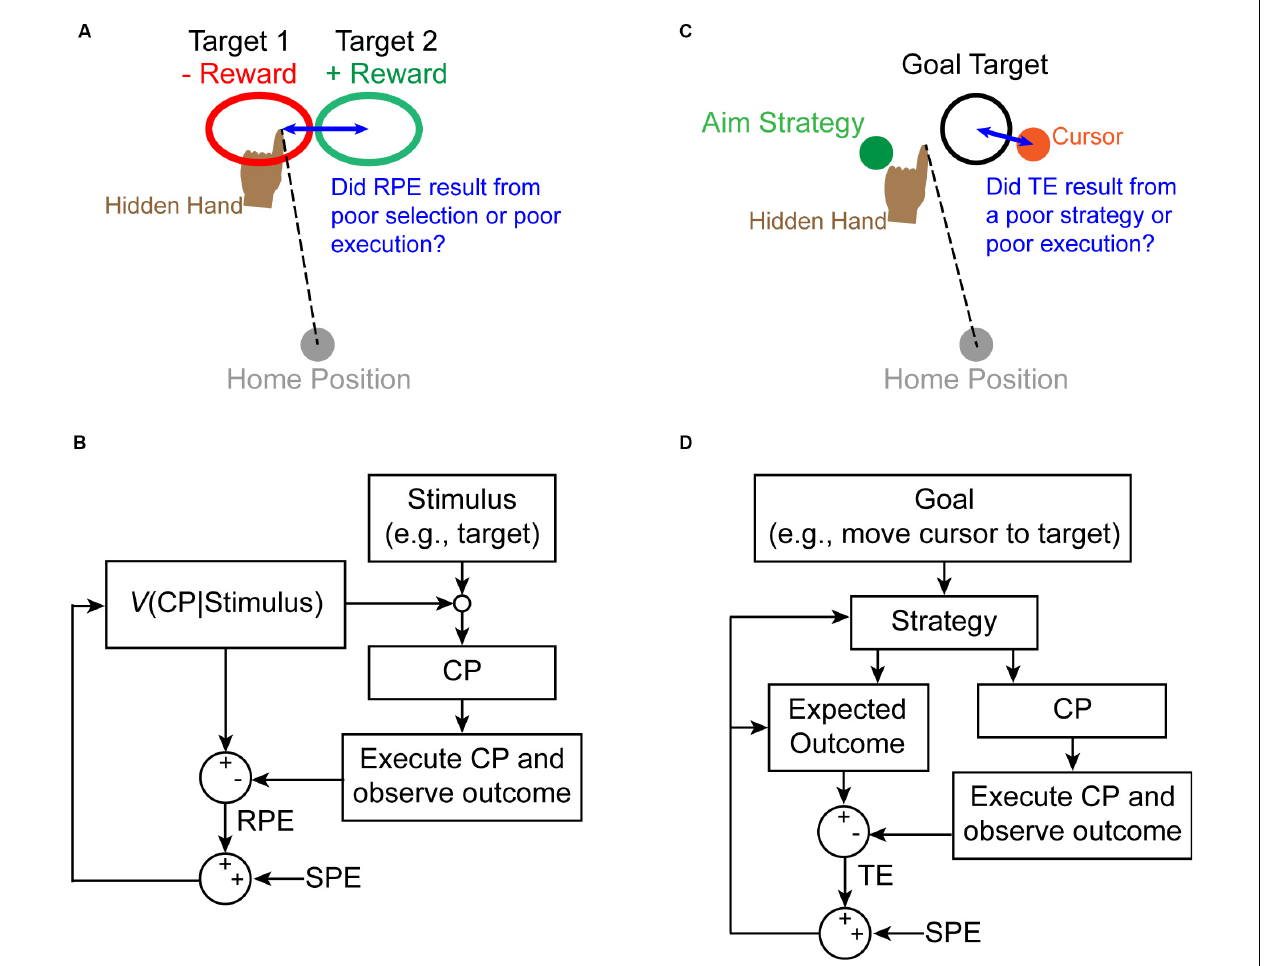
FIGURE 2 | Proposed interactions between the SPE signal and other learning mechanisms to solve the credit-assignment problem. (A) On a given trial, individuals receive positive or negative reward feedback about reach outcome. If this feedback is unexpectedly negative (i.e., a negative RPE signal), for example, individuals must determine whether they erroneously selected the wrong control policy or simply executed the correct policy poorly. (B) An example state diagram corresponding to the situation in panel (A) describes how an update signal is generated based on an RPE (indicating an error has occurred). An SPE is used to determine if the RPE should be attributed to a poor policy choice or a poor execution of that policy. (C) During explicit learning, an individual adopts a strategy (e.g., aim location) to attain a goal (hit the target with the cursor). If a task error arises, individuals must determine if they erroneously selected the wrong explicit strategy or if they poorly executed the correct strategy. (D) Although it remains unclear exactly how explicit learning occurs, we propose that updates to the strategy choice occur as a result of a task error (TE), which is modulated by an SPE informing about the accuracy of executing the chosen